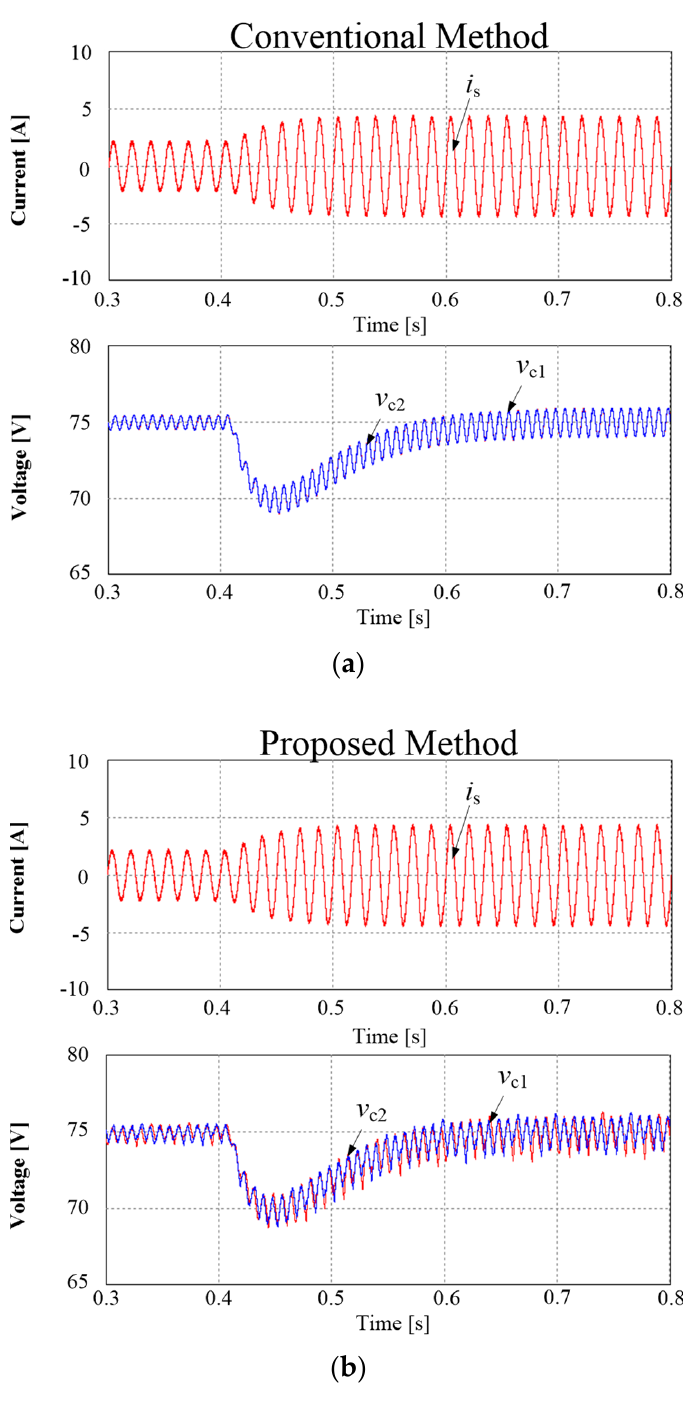
Figure 11. Simulation results of capacitor voltages ( v c1 , v c2 ) and source current with step change of load resistor from 200 Ω to 100 Ω obtained by ( a ) conventional method and ( b ) proposed method.